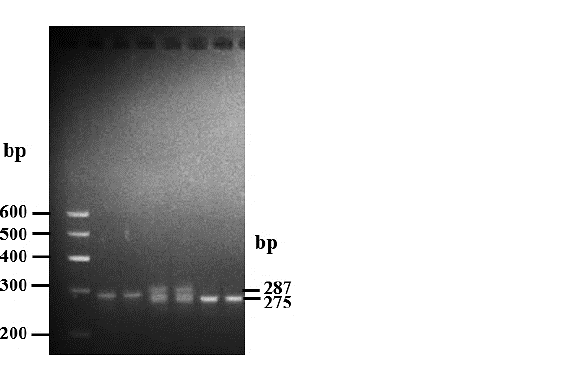
Figure 2. Electrophoresis pattern of the 12 bp deletion locus within the goat PRDM6 gene. Results with marker, wt/wt, wt/wt, wt/del, wt/del, del/del, del/del display. Wildtype, wt/wt; heterozygote genotype, wt/del, homozygote deletion genotype, del/del.